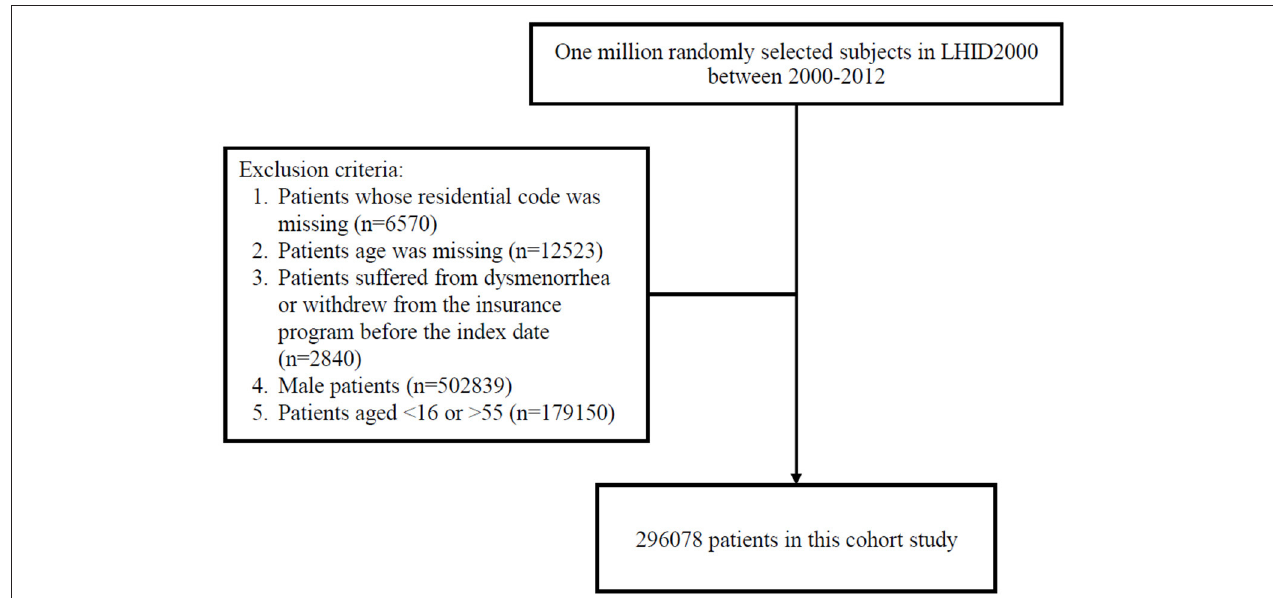
FIGURE 1 | Flow chart of this